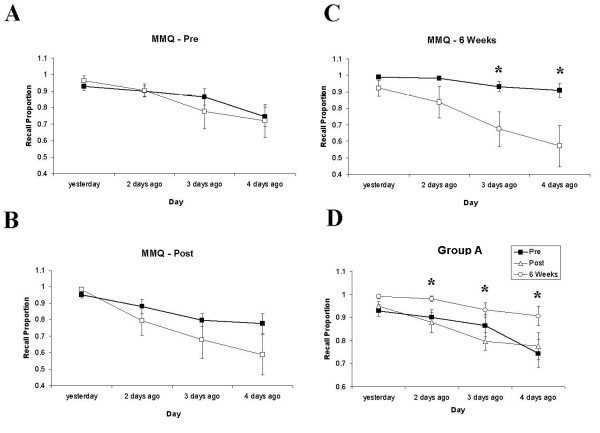
Behavioural data showing recall on the Mundane Memory Questionnaire at Pre-, Post- and 6 Weeks Post-training. MMQ recall scores for Group A (heavy line, filled squares) and Group B (thin line, empty squares) at Pre (A), Post (B) and 6 Weeks Post (C). Differences between groups were significant at 6 Weeks Post for information from 3 and 4 Days Ago, with superior recall in Group A. D) Within-groups recall increase for Group A across time points, showing improved recall for daily events at 6 Weeks Post relative to Post at 2 and 3 Days Ago, and for 6 Weeks relative to Pre for 2 and 4 Days Ago.